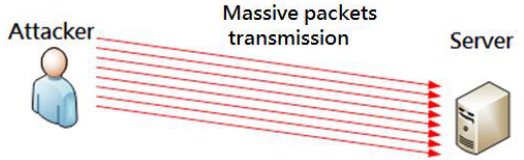
Figure 2. UDP flood attack diagram.